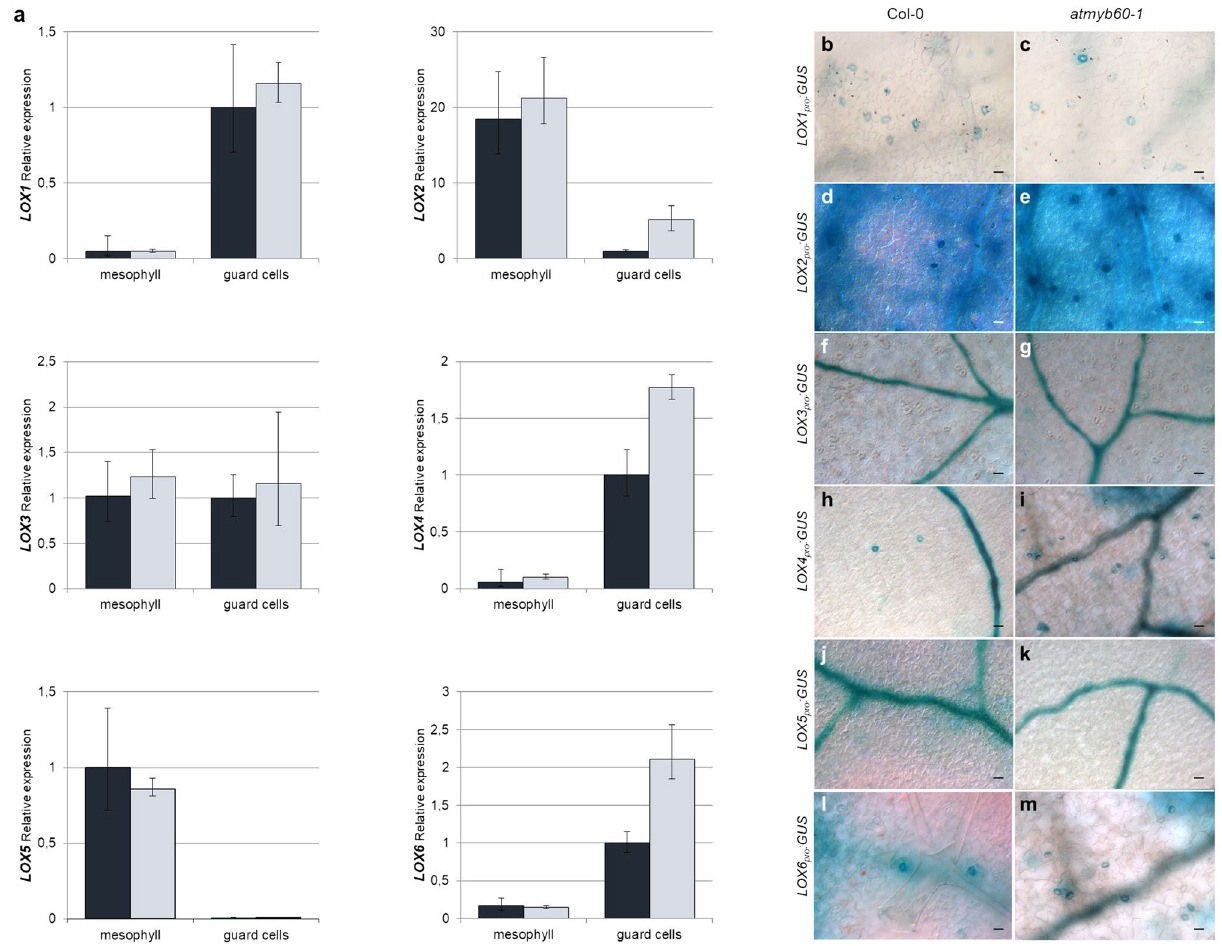
Figure 3. AtMYB60 negatively regulates expression of 13-LOX genes. ( a ) qPCR analysis of 9-LOXs ( LOX1 and LOX5 ) and 13 LOXs ( LOX2 , LOX3 , LOX4 and LOX6 ) expression in mesophyll or guard cells laser- microdissected from wild type or atmyb60-1 leaves. Relative gene expression was normalized to the expression of the AtACTIN2 gene. ( b – m ) Histochemical analysis of GUS activity in Arabidopsis stable transgenic LOXpro : GUS lines in the wild type (Col-0) or atmyb60-1 background. Developing leaves from 15-day-old plants were incubated in the staining solution for 24 h. Scale bars represent 20